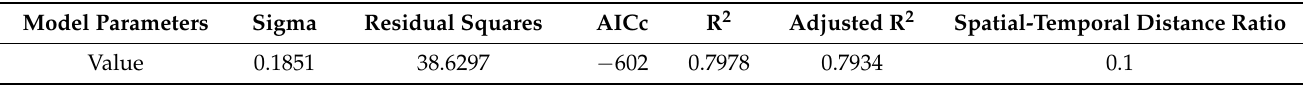
Table 6. Parameters of relevance for